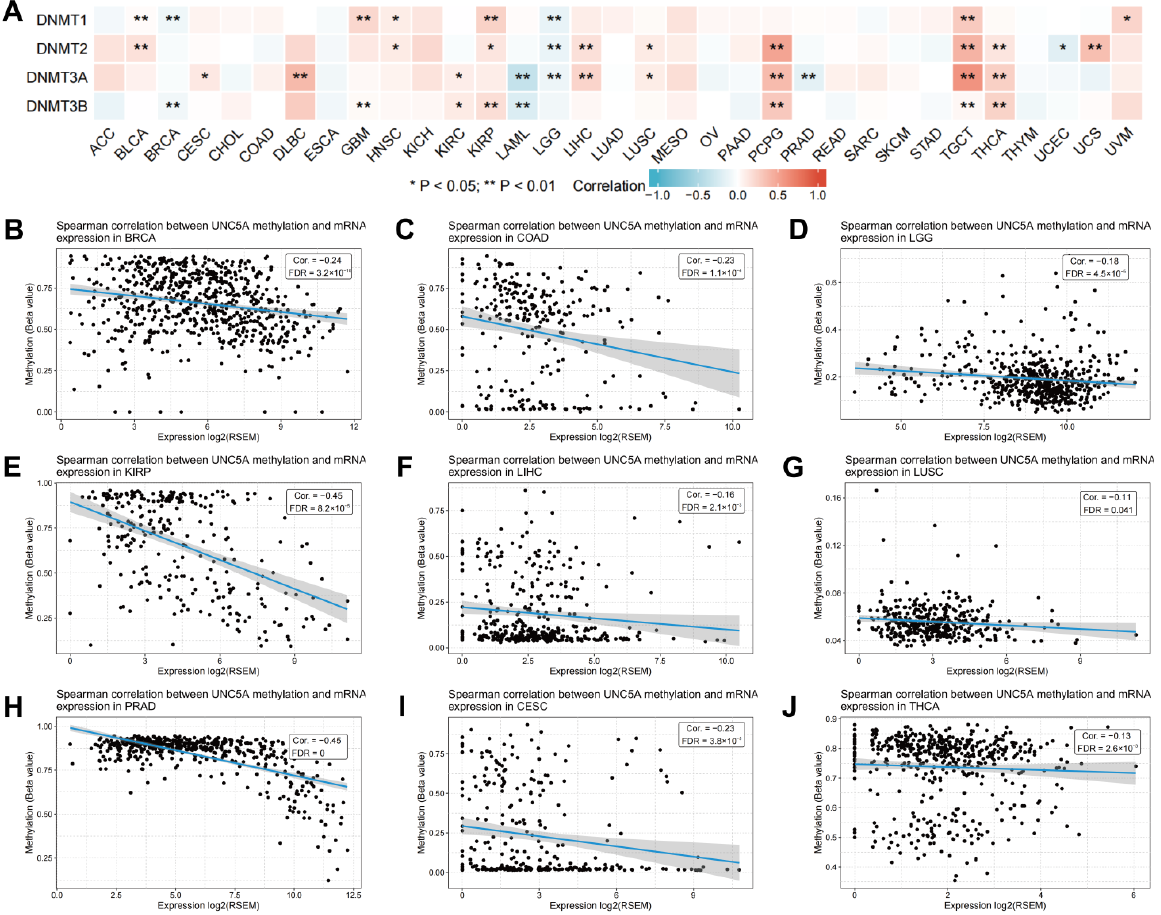
Figure 11. The relationship of UNC5A expression and DNA methylation status across cancer types.